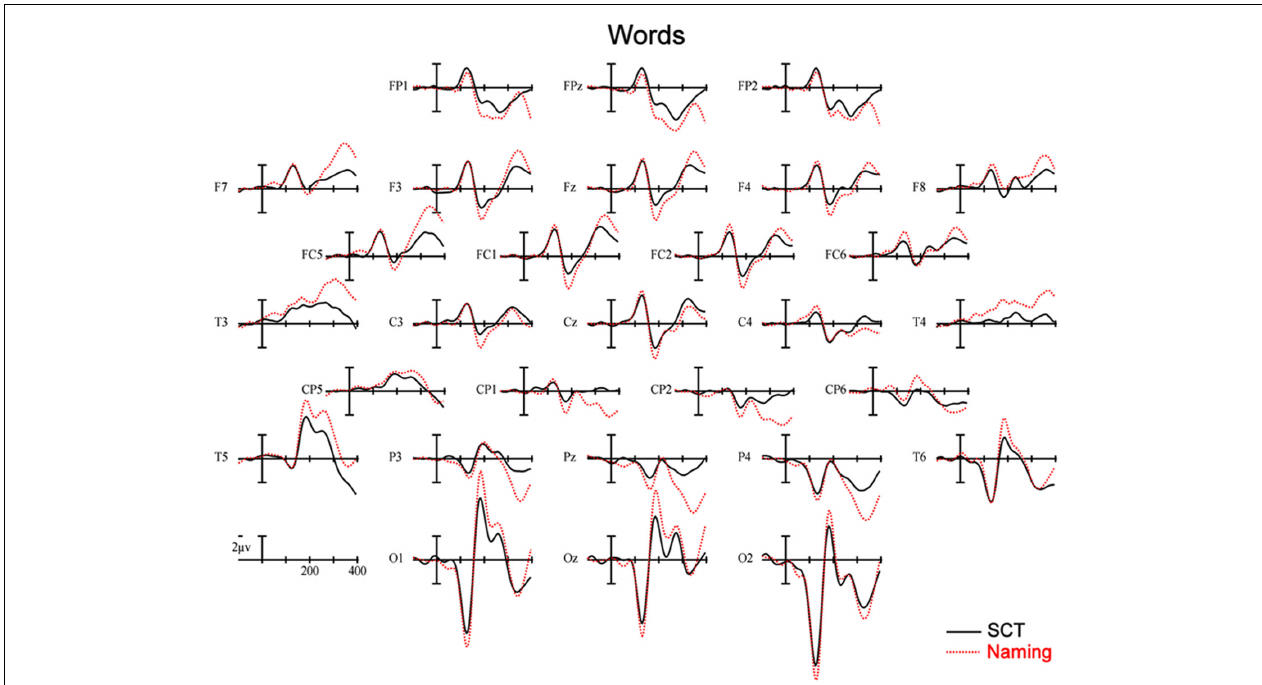
FIGURE 5 | Event-related potentials recorded to words, solid lines are ERPs during a semantic categorization task (SCT), and dashed lines are ERPs recorded in a word naming task.